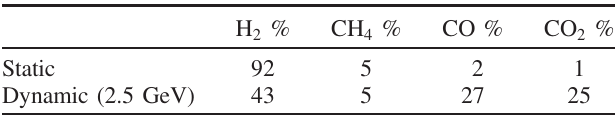
TABLE II. Residual gas composition of the BESTEX after bakeout. H 2 % CH 4 %